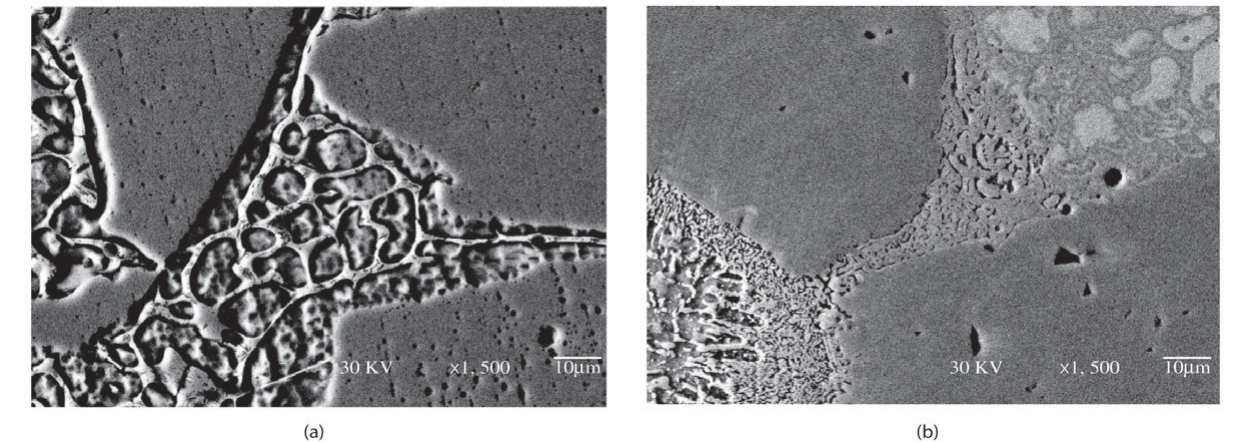
Figure 3. Scanning electron micrographies of Cr rich layer: a) before heating cycle; b) after heating